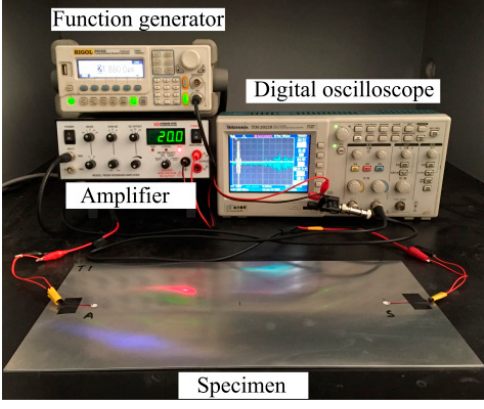
Figure 10. The testing equipment for the coupon test.